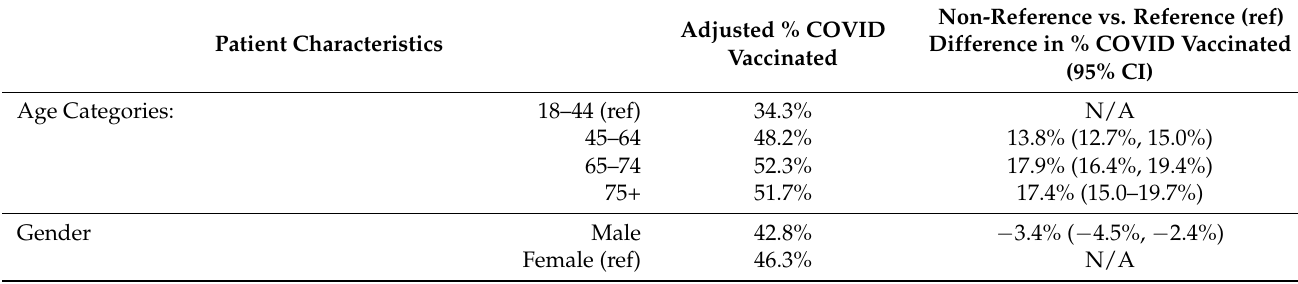
Table 2. Logistic regression predicting COVID-19 vaccination among Veterans experiencing homelessness. Patient Characteristics